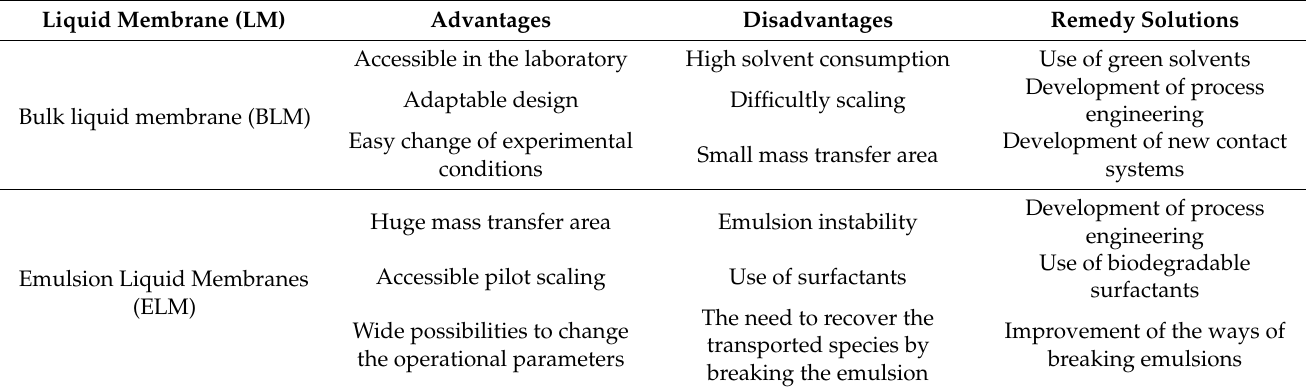
Table 3. Bulk liquid membrane (BLM) and emulsion liquid membrane